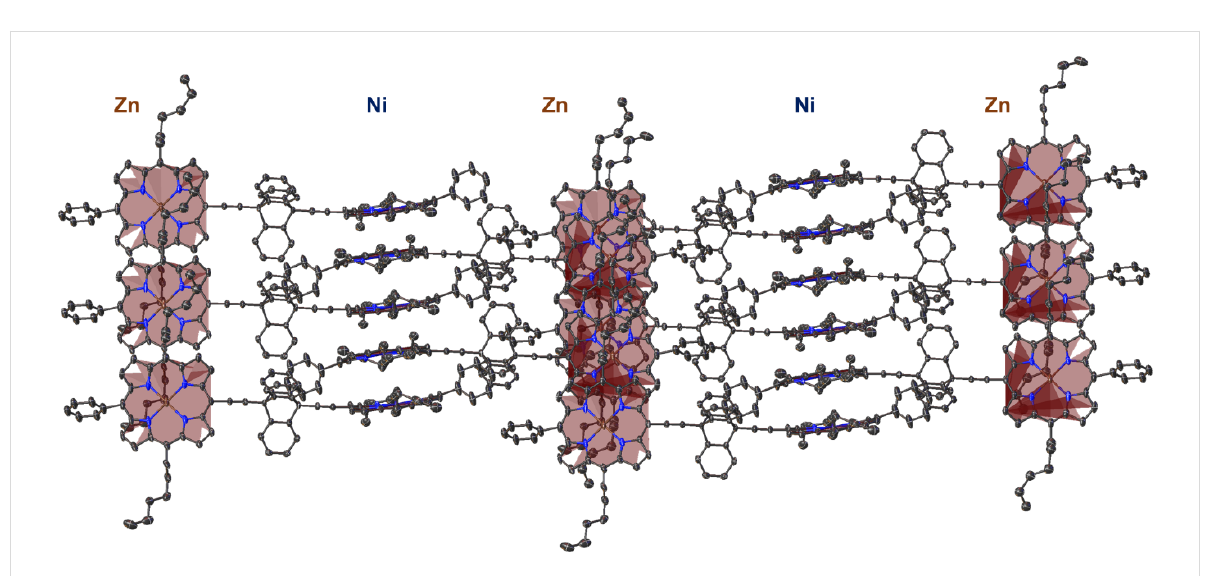
Figure 5: Expanded structure view of the triptycene-linked zinc-nickel porphyrin dimer 16 showing the repeating Zn···Ni···Zn···Ni network in the crystal lattice. Hydrogen atoms and minor disorder are omitted for clarity (thermal displacement 50%). Porphyrin macrocycle mean-planes are indicated by maroon